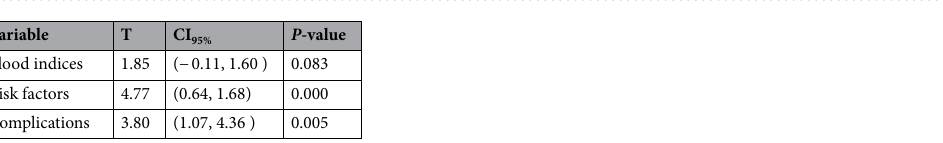
Figure 5. Forest plot of complications in survivors and non-survivors of COVID-19. The Standardized Mean Difference (SMD) and the 95% confidence intervals (CIs) were used to define the prevalence of various risk factors and complications for survivors and non-survivors of COVID-19. ARDS, acute respiratory distress syndrome; S, survivors; n, population size.